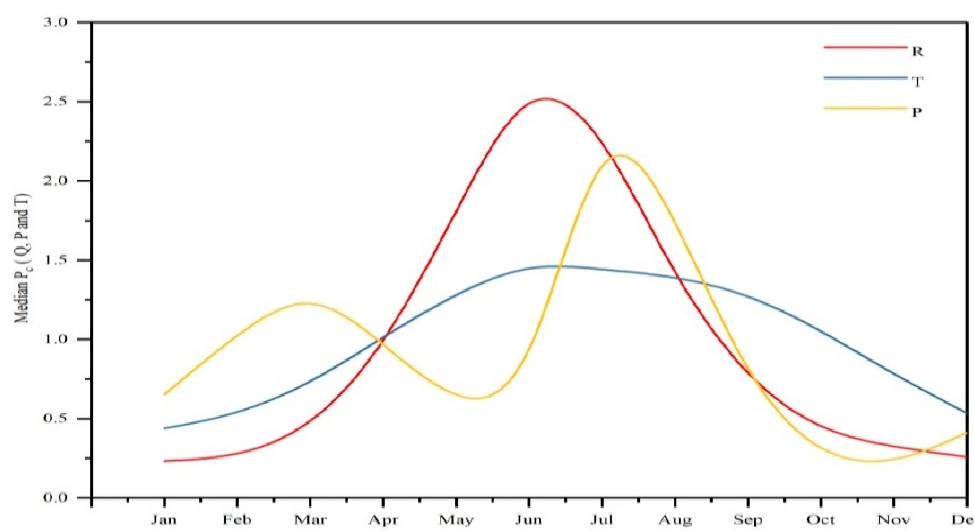
Figure 17. Comparison of different parameters of Zone II.